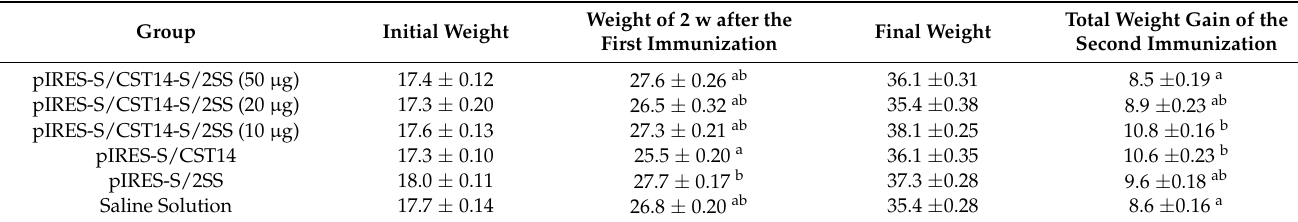
Table 1. Weight gain of mice immunized with various plasmids (mean ± SEM,